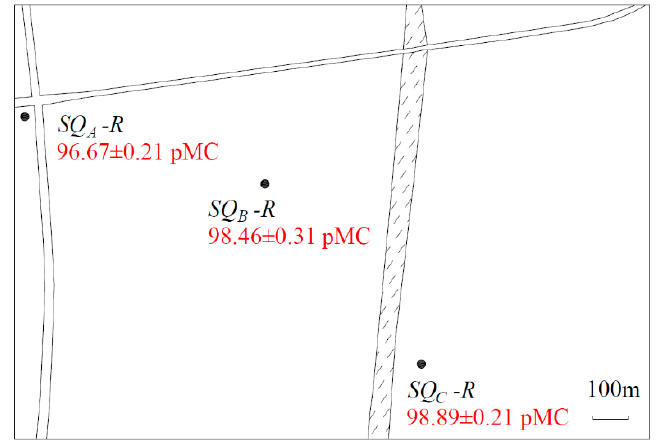
Figure 5. 14 C activity of Suqian ( SQ ) rice straw samples in different positions from fossil carbon sources.